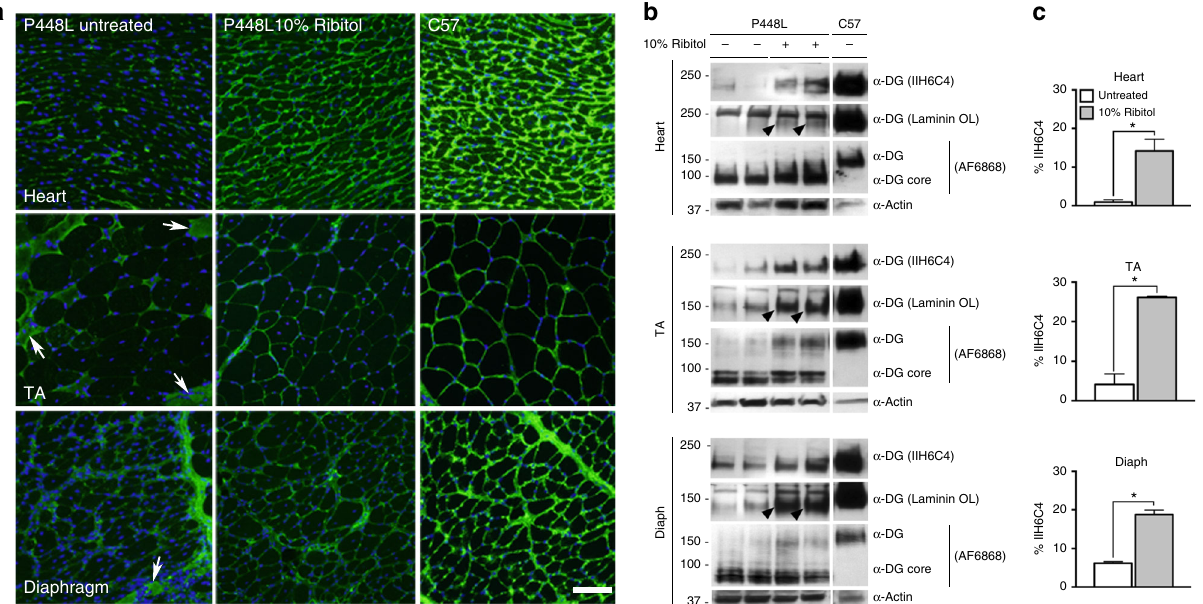
Fig. 6 Induction of F- α -DG in cardiac and skeletal muscles of P448L mice treated with 10% ribitol from pregnancy. P448L breeding females were treated with 10% ribitol in drinking water at onset of pregnancy with pups continuing to receive treatment for 19 weeks. Untreated P448L mice were given drinking water only. a Immunohistochemical staining with IIH6C4 antibody of cardiac (heart), tibialis anterior (TA), and diaphragm muscles from the untreated and 10% ribitol-treated P448L mice (left and middle panel, respectively) and C57 mice. Arrows indicate the degenerating fi bers with staining for cytoplasmic Ig. Scale bar, 50 μ m. Cellular nuclei were counterstained with DAPI (blue). b Western blot analysis of protein lysates from heart, TA and diaphragm (diaph) of two untreated ( − ) and two 10% ribitol-treated ( + ) P448L , and C57 mice. F- α -DG was detected by blotting with IIH6C4 and by laminin overlay assay (Laminin OL). Core of α -DG was detected by AF6868 antibody. Detection of α -actin was used as a loading control. c Quanti fi cation of IIH6C4 band intensity from western blot. Values were normalized to α -actin expression for each tissue and presented as percentage expression compared to C57 . Error bars represent mean ± SEM. Unpaired t test, * p ≤